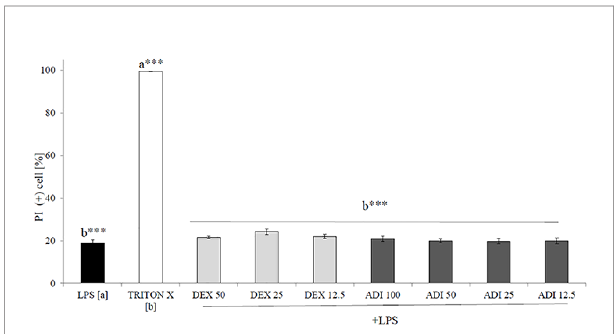
FIGURE 4 | The cytotoxic effect of ADI at concentrations of 12.5 - 100 µg/ mL on LPS-stimulated neutrophils after 24 h incubation [%], mean ± SEM. Statistical signi fi cance of differences was established by ANOVA with post hoc test, ***p<0.001, a*** - statistical signi fi cance of differences between LPS- stimulated control compared to control cells (Triton X), b - compared to control cells (Triton X).